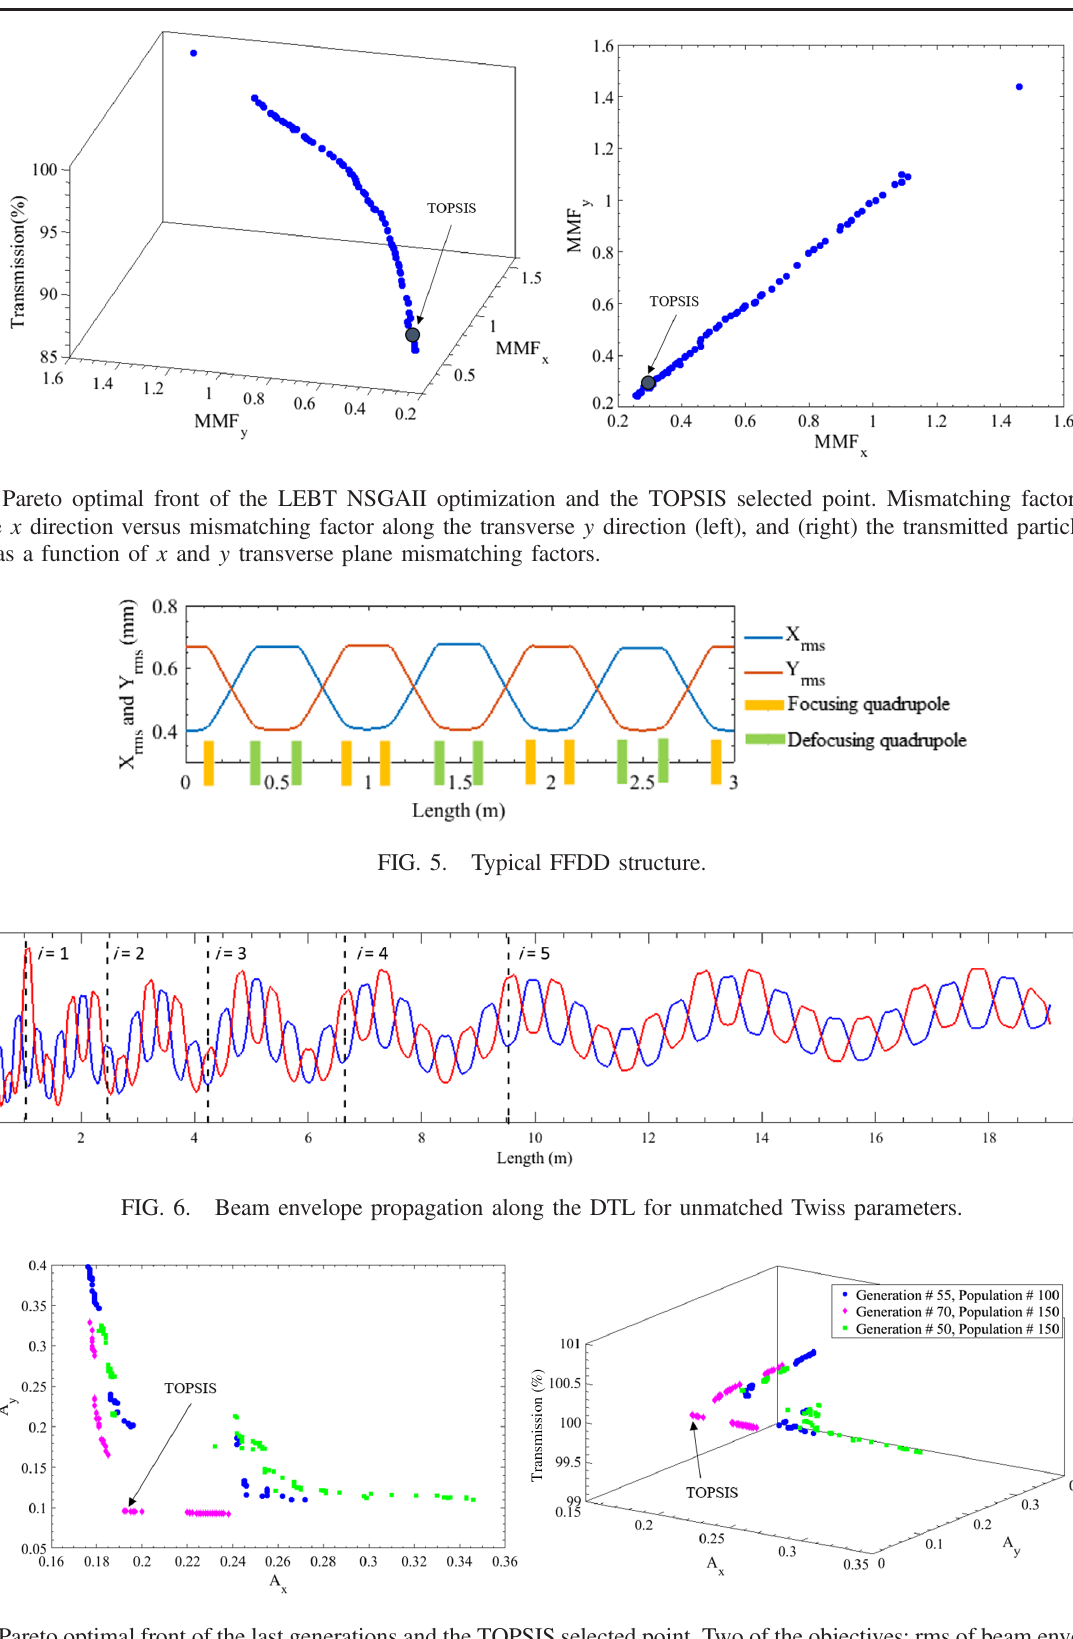
FIG. 7. Pareto optimal front of the last generations and the TOPSIS selected point. Two of the objectives: rms of beam envelope slope between two consecutive quadrupoles of identical polarity along the DTL in the two transverse planes, A x and A y (left). Three of the objectives, A x , A y , and the transmission along the DTL